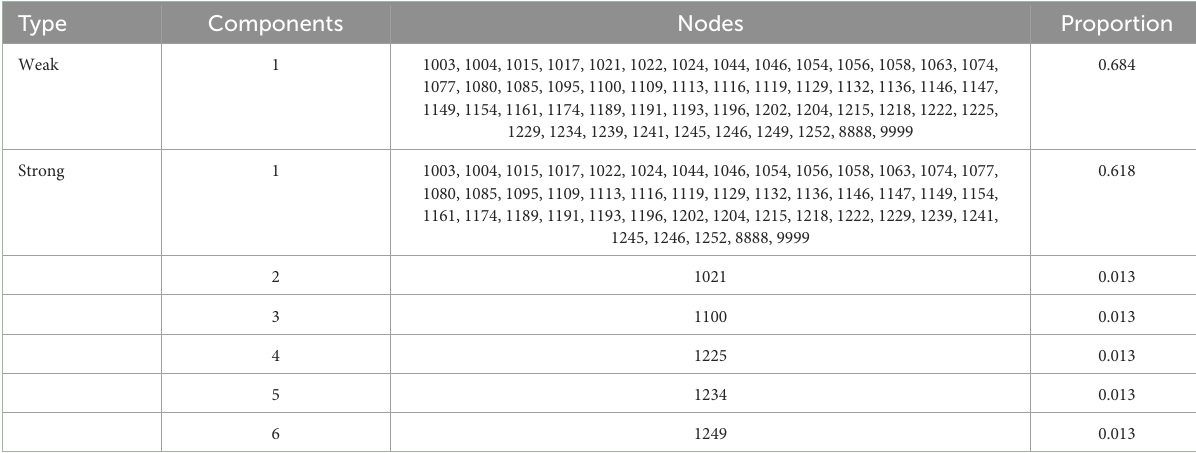
TABLE 2 The component of intervention group social network nodes except isolation nodes.